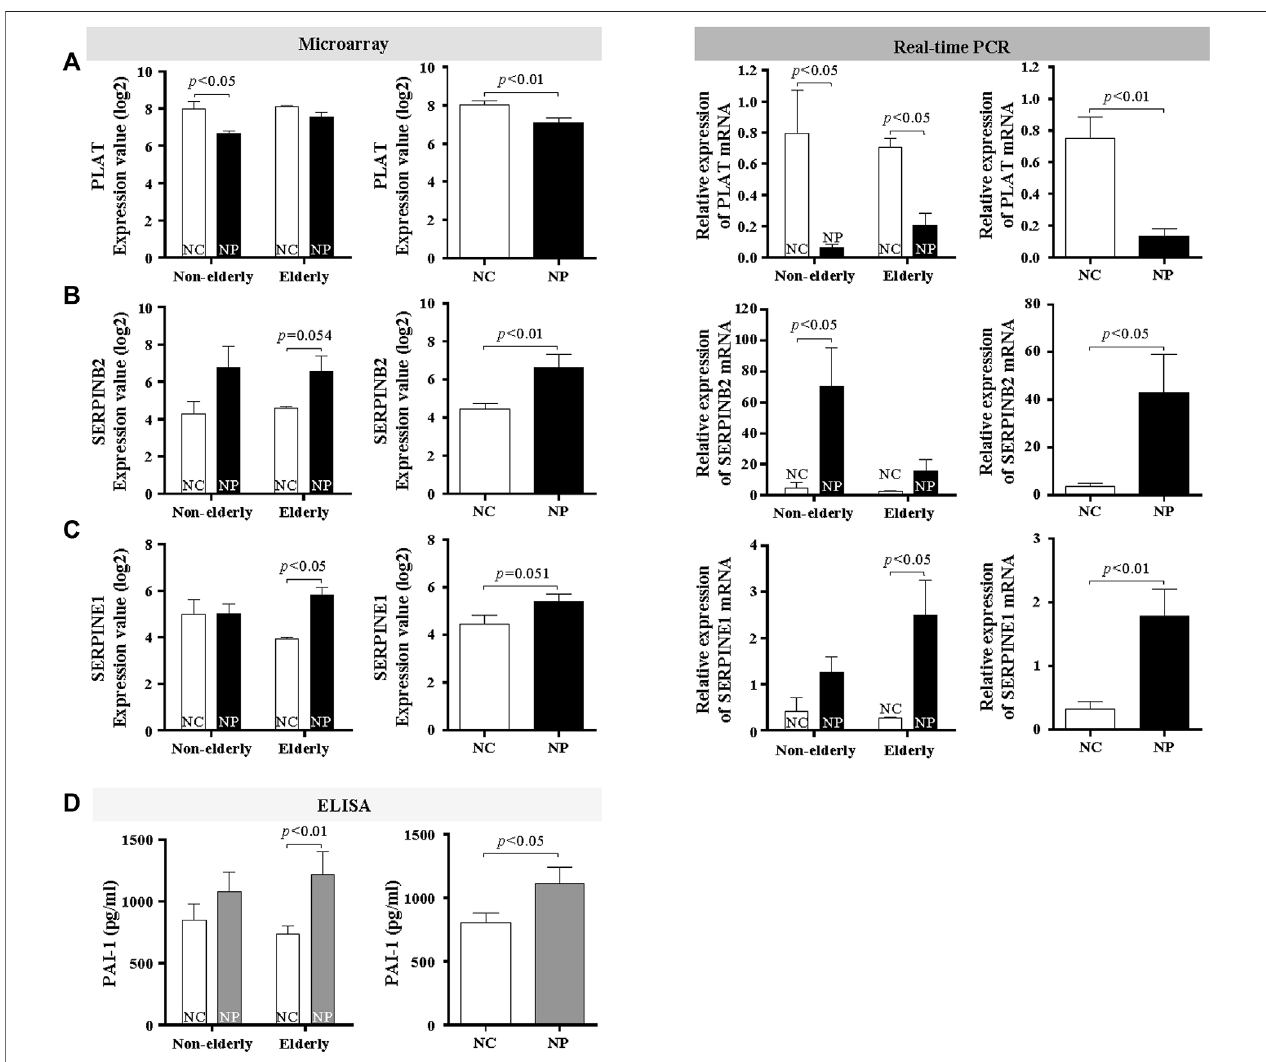
FIGURE6| Age-related difference incollagenand fi brindepositioninsubjectswithNPand normal controls. Microarray data andvalidationofmRNAexpression of fi brinolyticsystemgenesbyreal-timePCR (A) PLAT(Dataareexpressedasthemeans±SE;NCversusNP, n =16, p < 0.01), (B) SERPINB2(Dataareexpressedasthe means±SE;Non-elderlyNCversusNon-elderlyNP, n =8, p < 0.01),and (C) SERPINE1(Dataareexpressedasthemeans±SE;ElderlyNCversusElderlyNP, n =8, p < 0.01). (D) PAI-1proteinlevelswereassessedbyELISA.Dataareexpressedasthemeans±SE(ElderlyNCvs.ElderlyNP, n =15, p < 0.01).NC,normalcontrol;NP, nasal